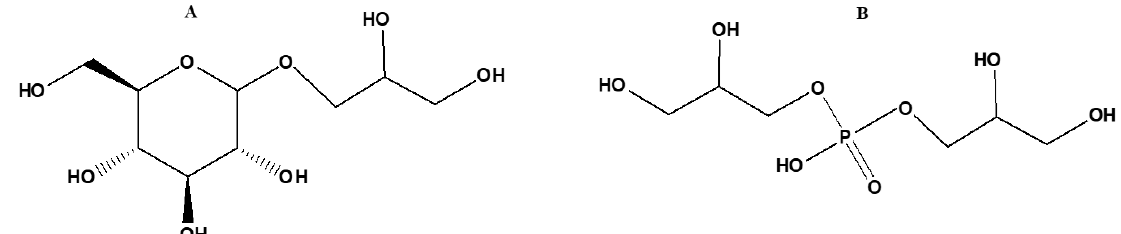
Figure 6. Important derivatives of glycerol in thermophiles as discussed in the text [78]: (A) glucosyl glycerol, which is a non-phosphorylated derivative of glycerol and is formed by the condensation reaction of glycerol with glucose via glycosidic bond and (B) diglycerol phosphate, formed by the condensation reaction between two units of glycerol and a phosphate group.